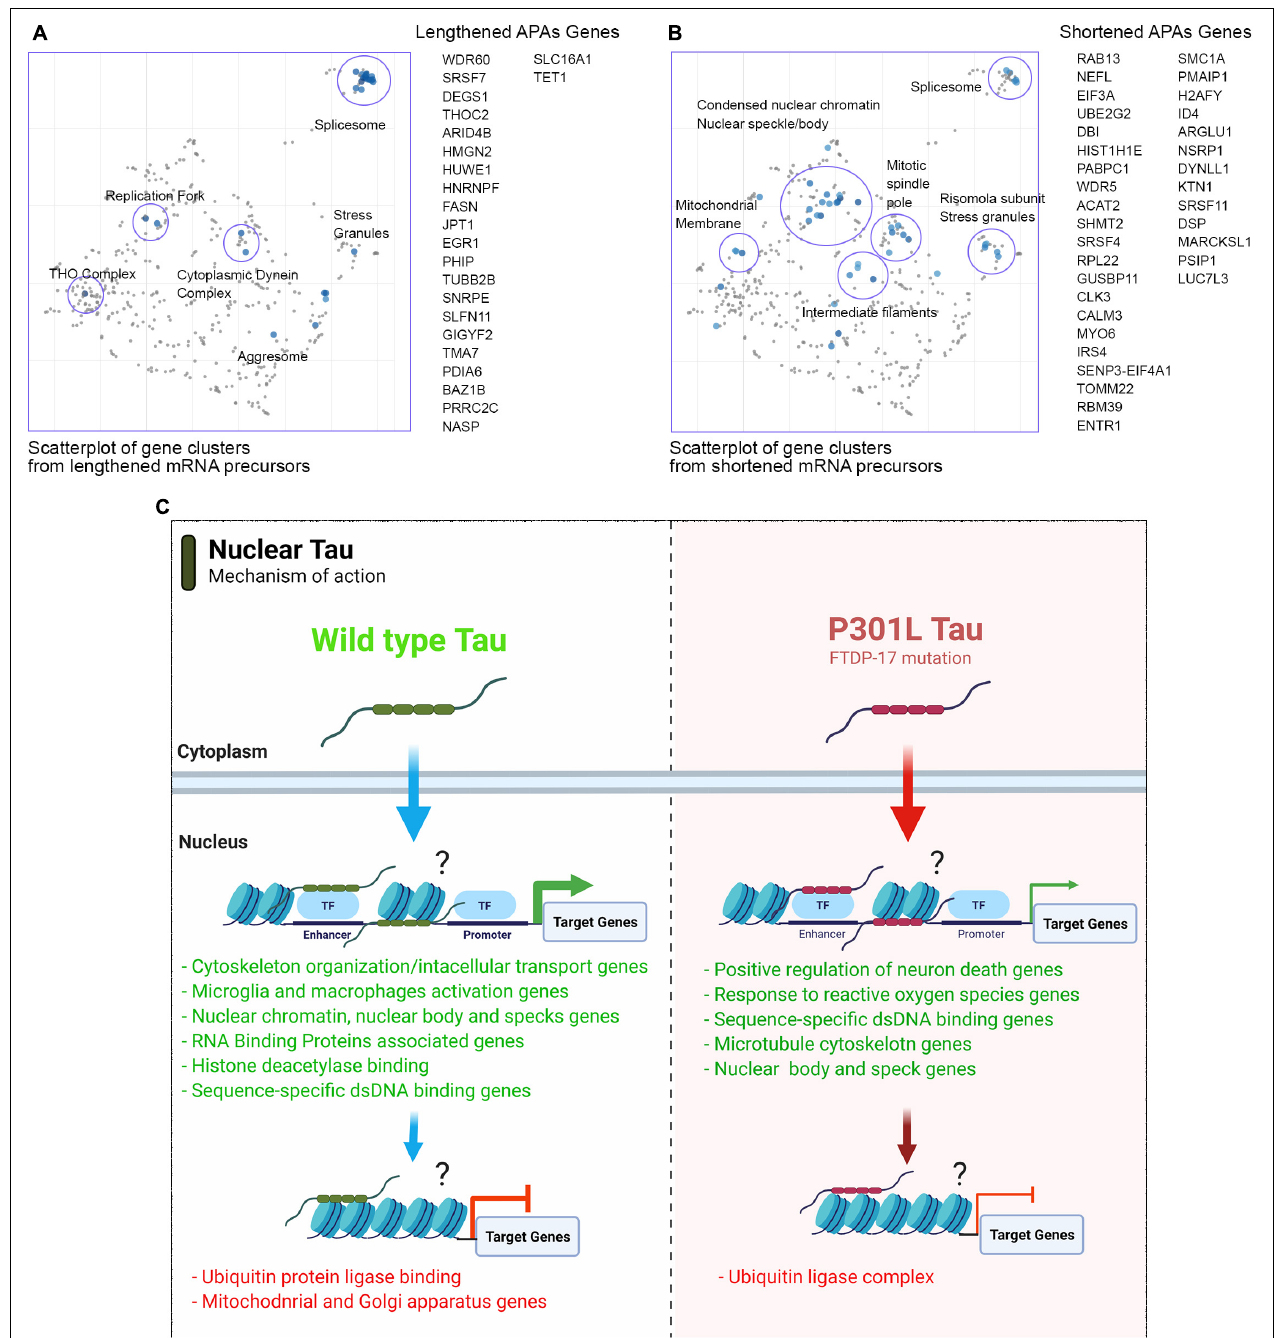
FIGURE 7 | Mutant P301L tau modulates APAs associated with spliceosome and nuclear chromatin. (A) Scatterplot of gene clusters from lengthened mRNA precursors upon P301L Tau expression. (B) Scatterplot of gene clusters from shortened mRNA precursors upon P301L Tau expression. (C) Model for nuclear tau activity to transcriptional and post-transcriptional